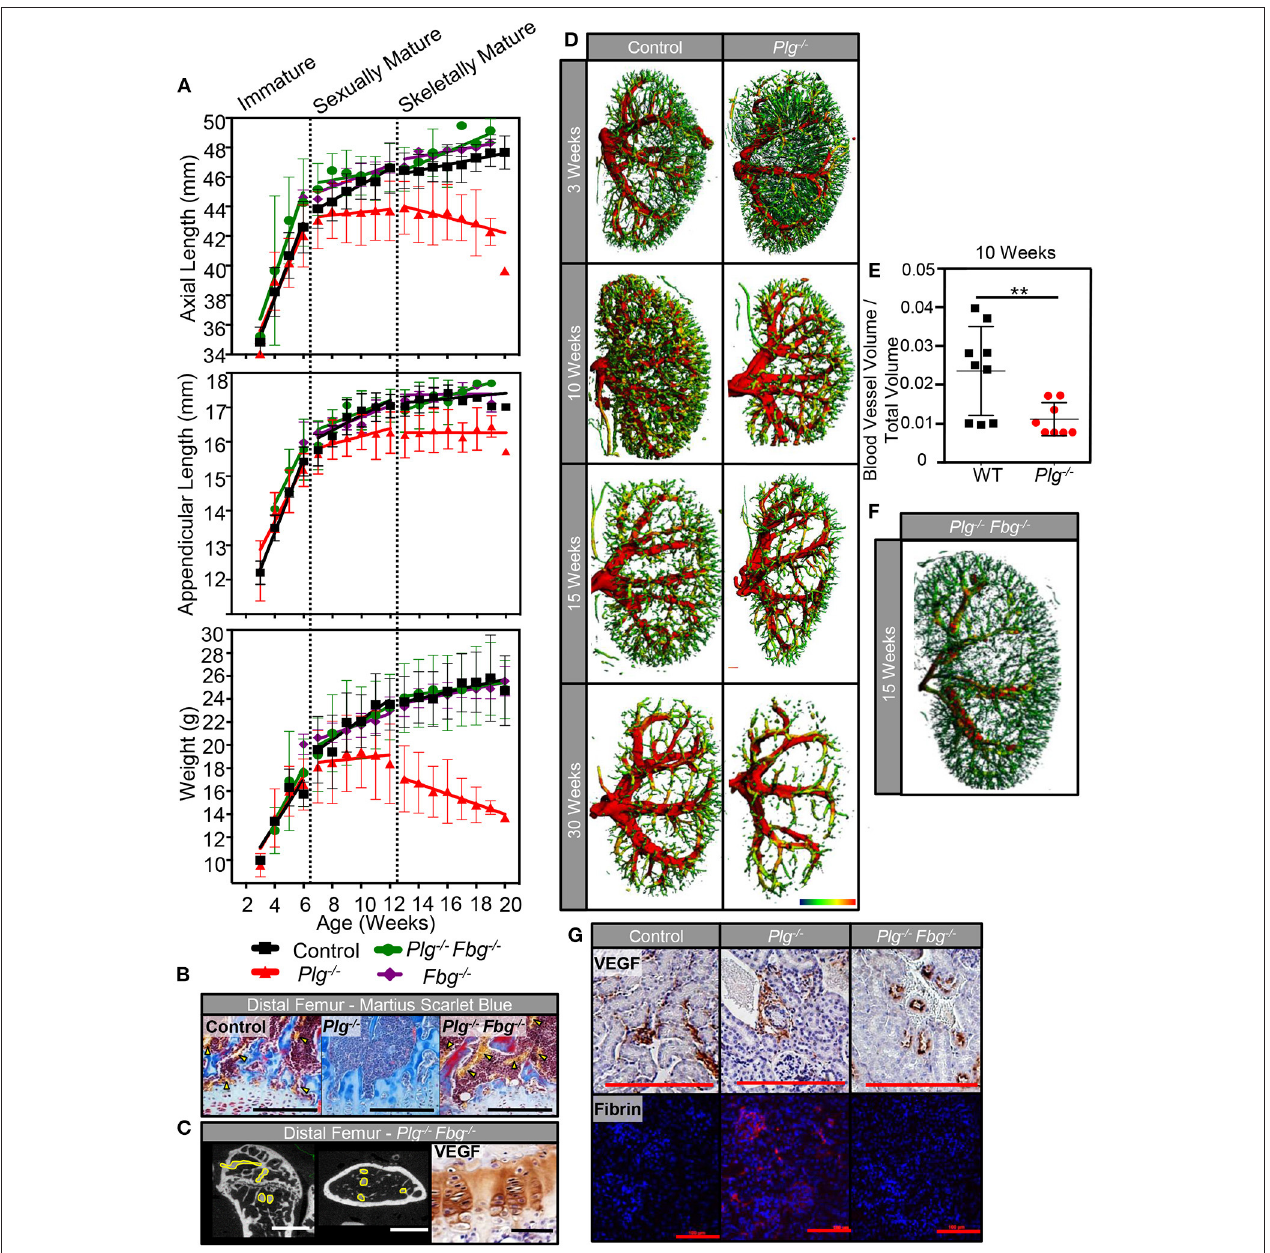
FIGURE 7 | Genetic reduction of fibrin(ogen) rescues skeletal development and reduction in systemic vascularity associated with impaired fibrinolysis. (A) Serial body weight, axial, and appendicular skeletal length (measured radiographically) of WT control, Plg − / − , and Plg − / − Fbg − / − mice during immature, sexually mature, and skeletally mature growth phases. (B) Histological examination of the distal femurs from WT control, Plg − / − , and Plg − / − Fbg − / − mice at 20 weeks of age demonstrated preservation of the metaphyseal blood supply in Plg − / − Fbg − / − mice, compared to the complete absence of vasculature in Plg − / − mice [Martius scarlet blue stain; erythrocytes are stained yellow and physeal vessels are indicated with yellow arrowheads (10 × , scale bars, 100 µ m)]. (C) Angiography of distal femurs shows an intact metadiaphyseal vasculature in Plg − / − Fbg − / − mice at 20 weeks of age [2D µ CT, vasculature outlined in yellow (scale bars, 1mm)]. There was no detectable change in VEGF immunoreactivity seen in the distal physes of Plg − / − Fbg − / − mice as measured by immunohistochemical staining (40 × , scale bars, 25 µ m). (D) Kidneys from Plg − / − mice and WT control littermates were analyzed by 3D µ CT angiography at 3, 10, 15, and 30 weeks of age for renal vascularity. While both control and Plg − / − kidneys undergo a reduction in renal vascularity with age, Plg − / − mice appear to lose renal microvasculature at an accelerated rate beginning at 10 weeks of age. (E) Quantification of blood vessel volume and total tissue volume obtained from µ CT following angiography of Plg − / − mice and control littermates at 10 weeks of age (** p < 0.01). (F) Kidneys from Plg − / − Fbg − / − at 15 weeks of age (following skeletal maturity) were analyzed by 3D µ CT angiography to demonstrate rescue of the renal vasculature when fibrin(ogen) is genetically reduced in the setting of plasminogen deficiency. (G) Immunohistochemical staining for VEGF in the glomeruli of Plg − / − , and Plg − / − Fbg − / − , and WT control littermates following skeletal maturity (20 × , scale bars, 100 µ m). Immunolocalization of fibrin within glomeruli of Plg − / − , Plg − / − Fbg − / − , and WT control littermates following skeletal maturity (10 × , scale bars, 100 µ m).